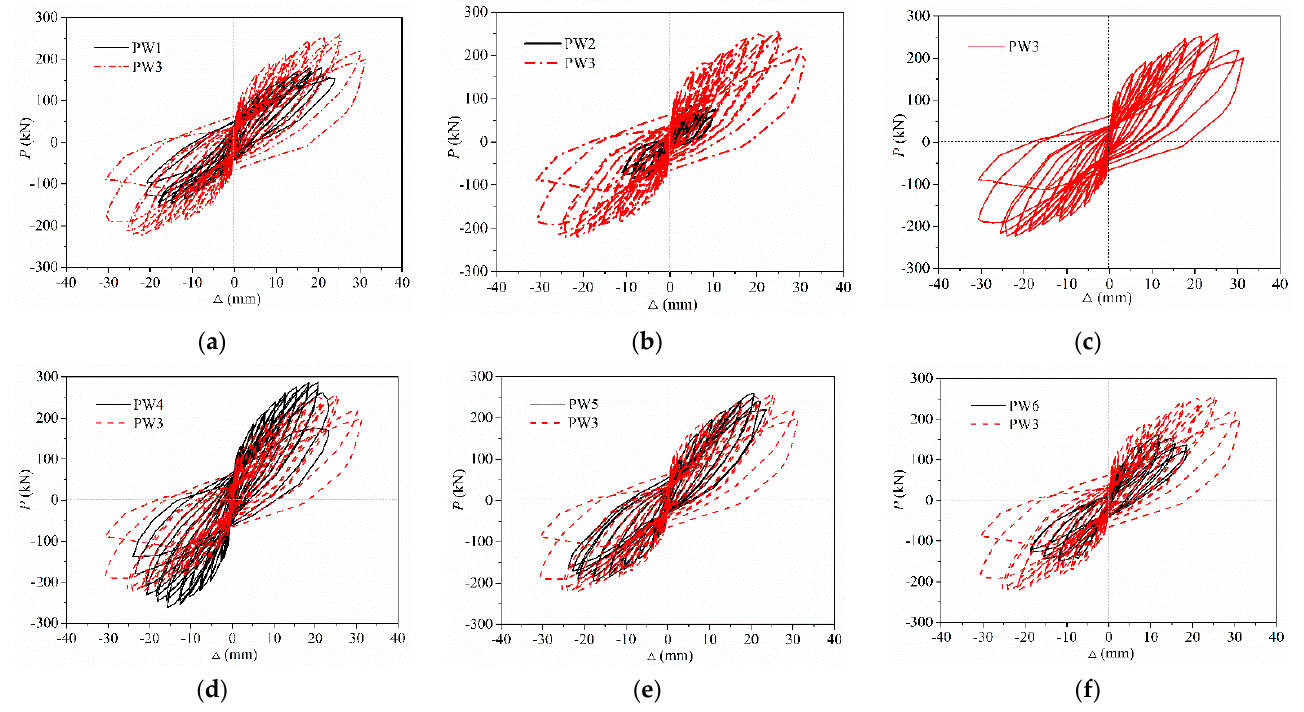
Figure 9. Hysteretic curves of PW1–PW6: ( a ) PW1; ( b ) PW2; ( c ) PW3; ( d ) PW4; ( e ) PW5; and ( f ) PW6.